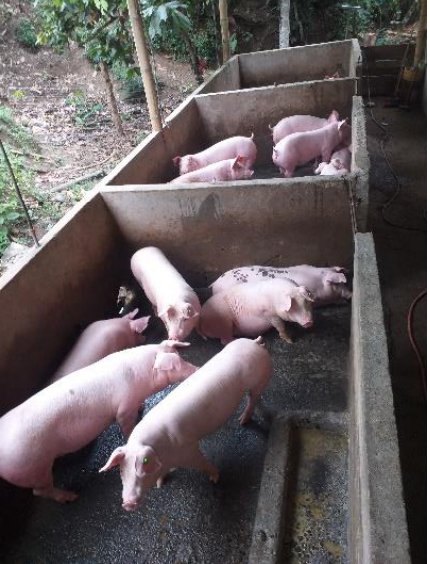
Figure 2. Pigs used and the pigsties employment in the trial.